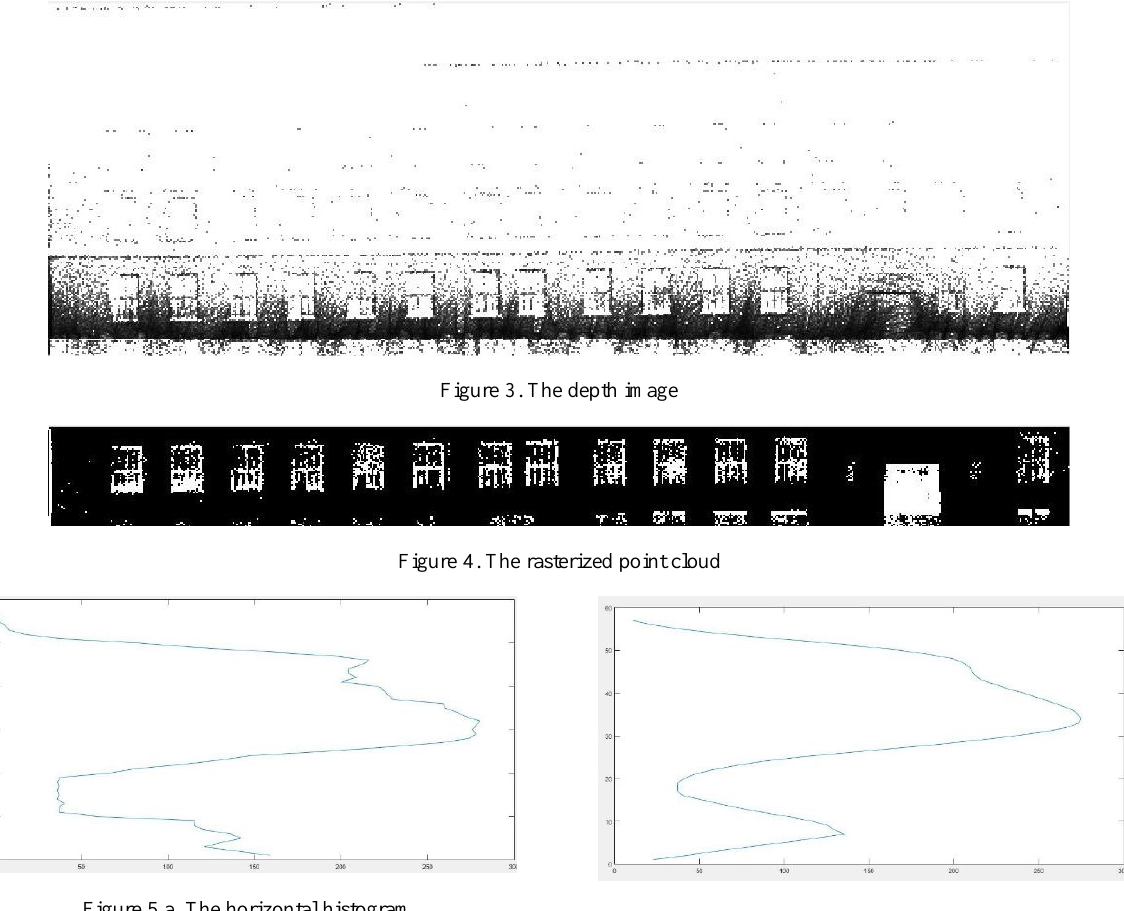
Figure 5.b. The smoothed horizontal